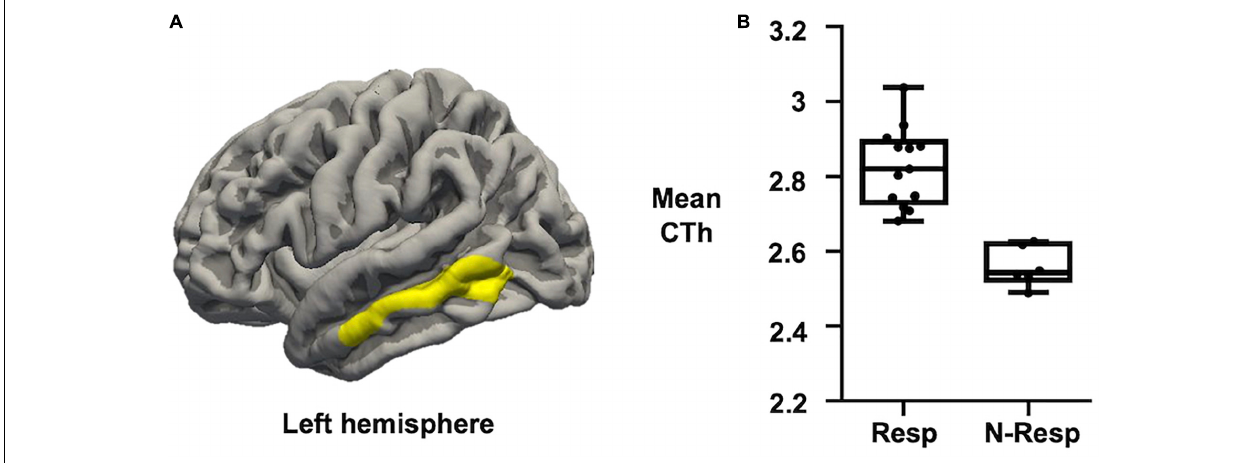
FIGURE 3 | (A) Map of CTh showing that active-tDCS responders exhibited thicker left middle temporal lobe than active-tDCS non-responders. Only clusters surviving FWE multiple comparison correction with a final cluster-wise p < 0.05 are considered. (B) Plot showing that Resp exhibited higher CTh than N-Resp (mean CTh values extracted from the significant cluster over the left middle temporal lobe). CTh, cortical thickness; FWE, family-wise error; Resp, responders; N-Resp,